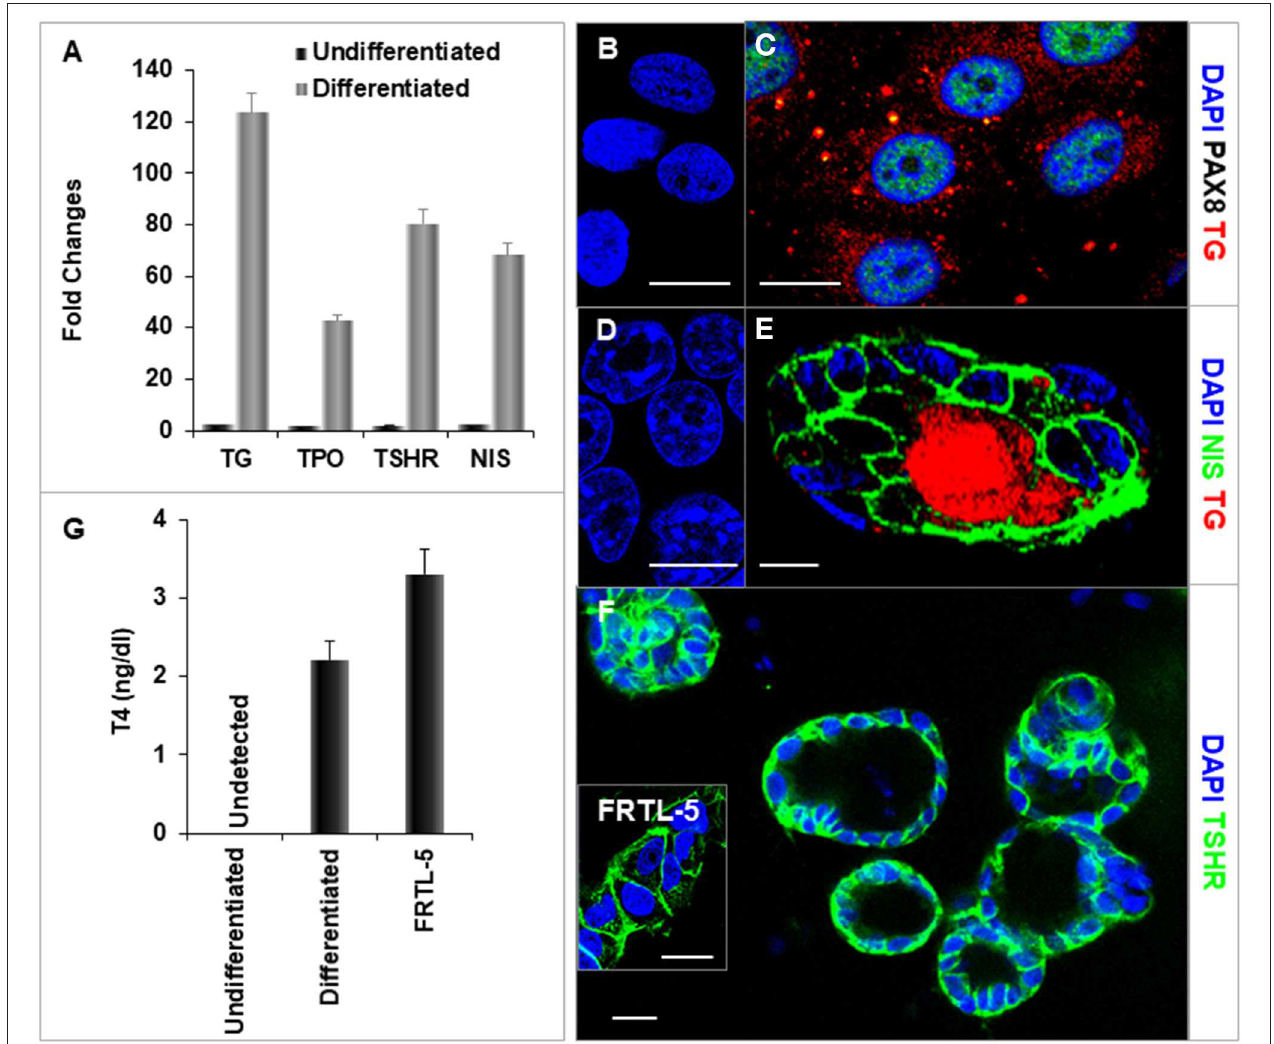
FIGURE 6 | Characterization of differentiated thyroid cells. (A) qPCR analysis of thyroid specific genes: TG, TPO, TSHR, and NIS. Fold change is represented as the mean ± SEM of three independent experiments on differentiated LF cells at 21 days. (B–F) Immunostaining of thyroid genes in undifferentiated and differentiated LF cells at 21 days culture: (B,D) Undifferentiated cells as a control. (C) Staining of TG (Red) and PAX8 (Green) in differentiated cells. TG expressed in cytoplasm and PAX8 expressed in nucleus. (E) Staining of TG (Red) and NIS (Green) in a differentiated thyroid follicle: NIS was expressed in the membrane and TG was expressed in the cytoplasm and follicular lumen. (F) Thyroid neo-follicles derived from differentiated cells expressing TSHR (Green) in the membrane. Inset shows staining of rat FRTL-5 thyroid cells. Scale bar = 20 µ m. (G) Measurement of T4 from the differentiated LF cells: T4 was detected in the iodine supplemented medium of the differentiated LF cells at 23 days culture as described in Methods and was absent in the medium of the undifferentiated cells but less than in FRTL-5 cells with 7H medium.